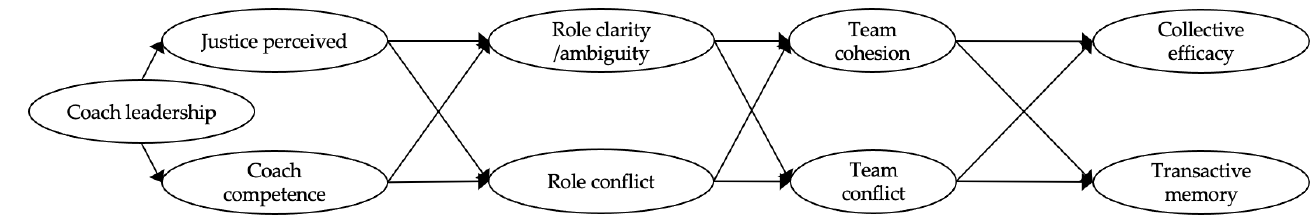
Figure 4. The hypothesized Model 3 of the relationships among variables.